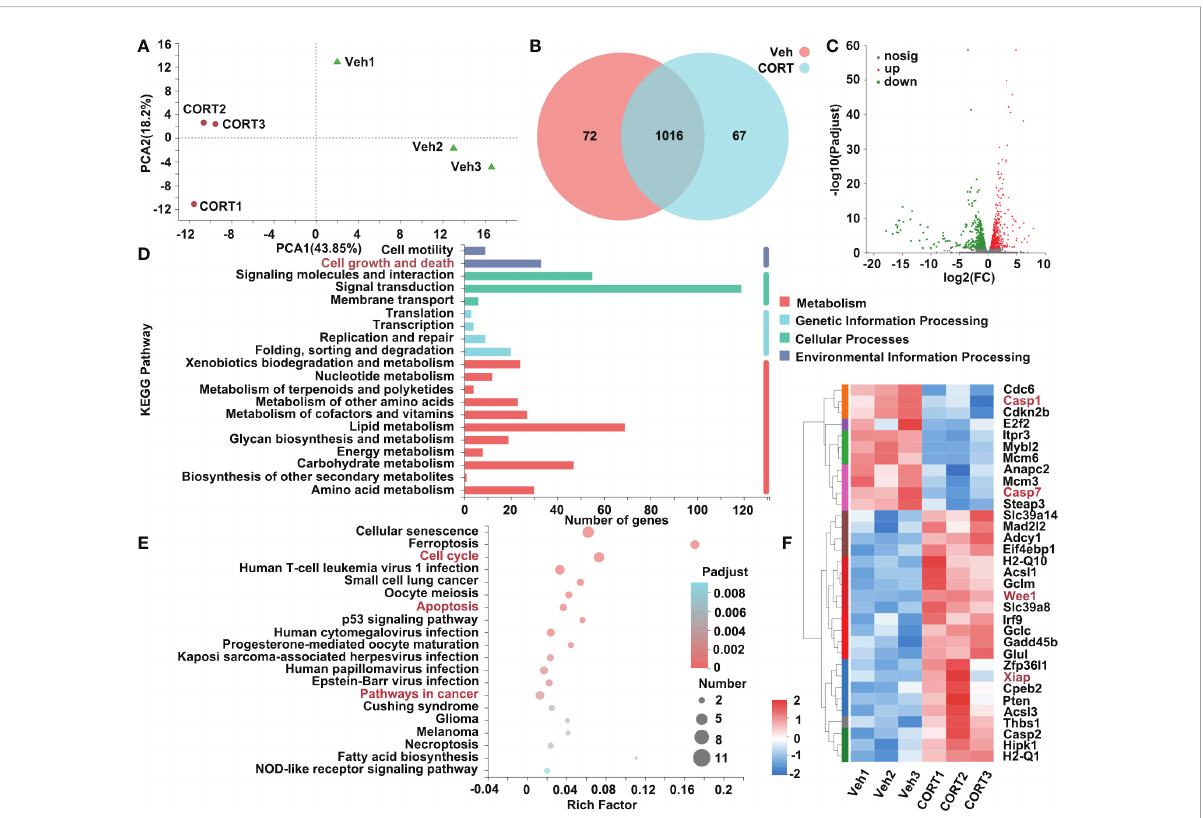
FIGURE 3 Identi fi cation of genes that were differentially expressed in intestines in response to CORT treatment. (A) Principal component analysis of the transcriptome of the intestine samples collected from the mice administrated with CORT or Vehicle. (B) Venn diagram displaying the distribution of DEGs (genes with > 1.5-fold change in expression) for the intestine samples of the two groups. If the TPM value of the gene was lower than 1, the gene was considered to be not expressed in the intestines of the group. (C) Volcano plots of the DEGs for intestines of the 2 groups. The up-regulated genes are presented by red dots, and the down-regulated genes are presented by green dots. (D) The functional classi fi cation of DEGs for intestines of the 2 groups based on fi rst-category KEGG pathway analysis. (E) The functional classi fi cation of DEGs for intestines of the 2 groups based on second-category KEGG pathway analysis. (F) Heatmap of DEGs for intestines of the 2 groups in the category of “ cell growth and death ” . Veh: vehicle-treated group; CORT: corticosterone-treated